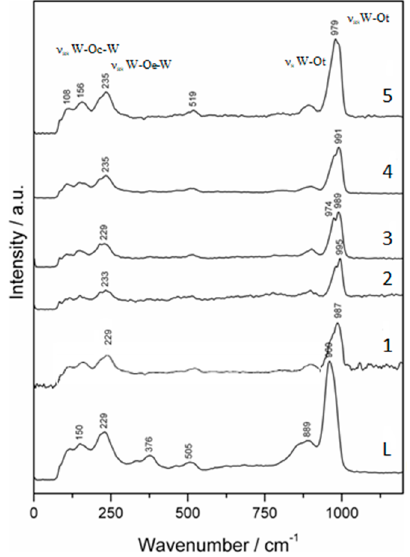
Figure 7. The Raman spectra of ligand L and complexes 1–5.